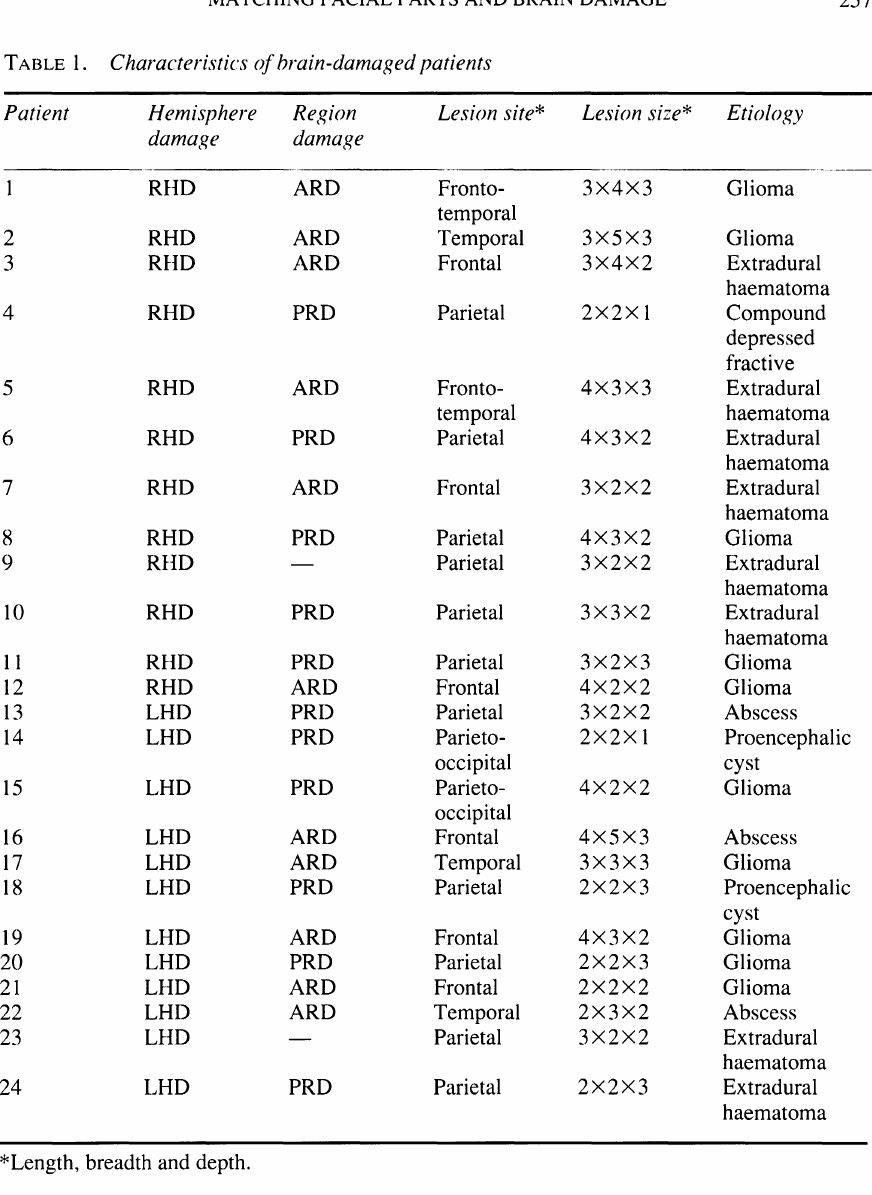
TABLE I. Characteristics of brain-damaged patients